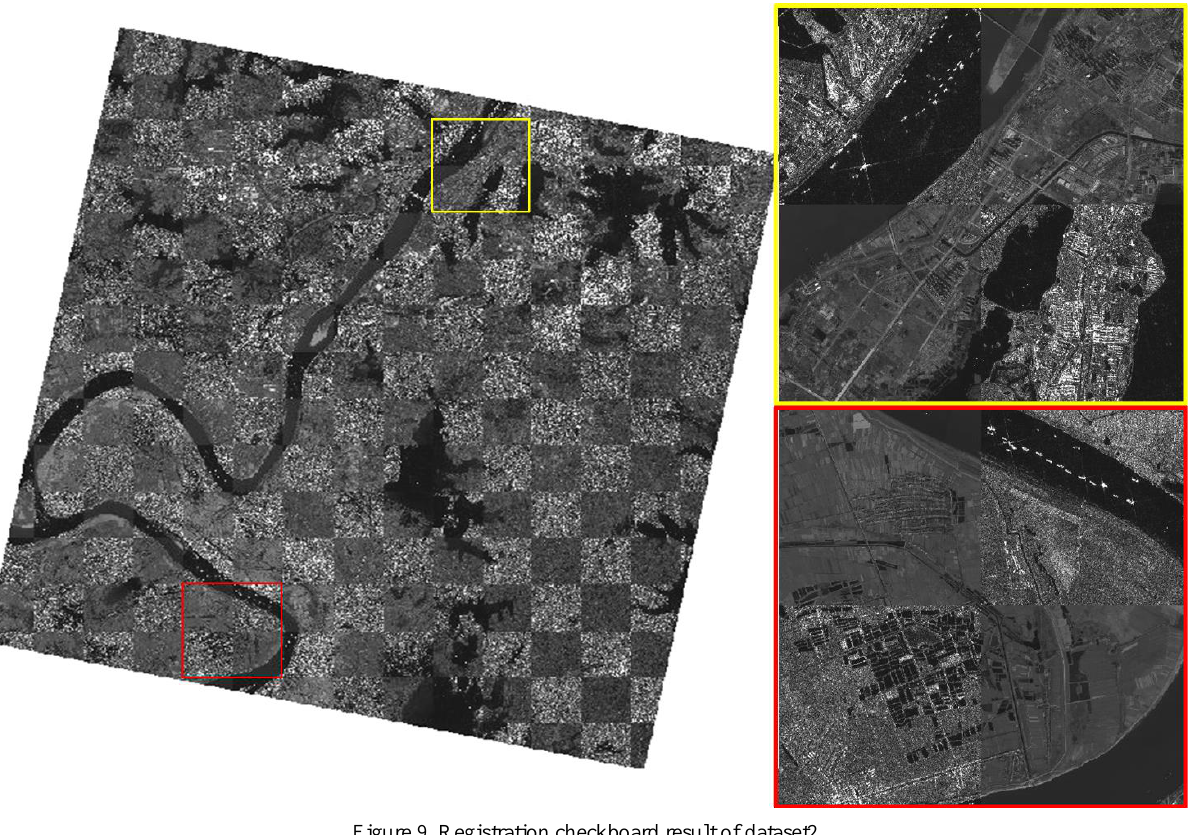
Figure 9. Registration checkboard result of dataset2